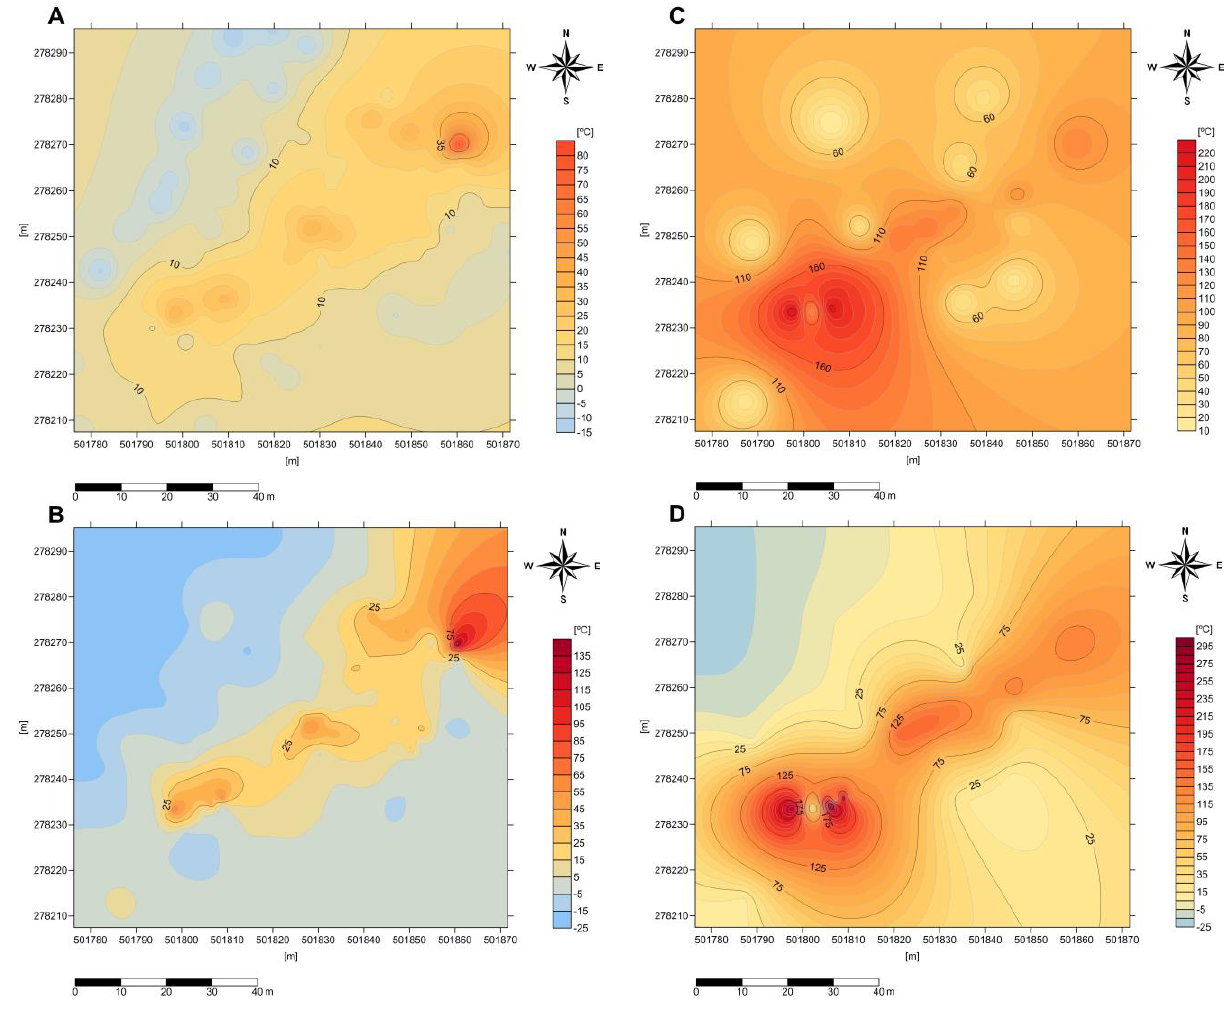
Fig. 4. Isotherm maps, referring to the temperature measured on the surface and inside the "Wojkowice" spoil tip, generated by means of IDW and RBF ETRS89/Poland CS92: A – temperature distribution on the heap surface obtained by the use of IDW; B – temperature distribution on the heap surface obtained by the use of RBF; C – temperature distribution inside the heap obtained by the use of IDW; D – temperature distribution inside the heap obtained by means of RBF